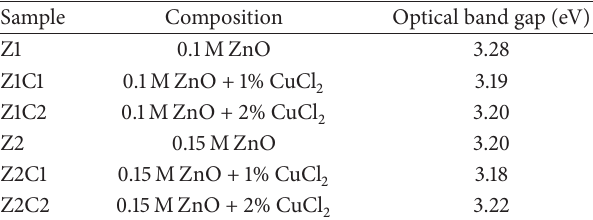
Table 2: Optical band gap of Cu doped ZnO thin